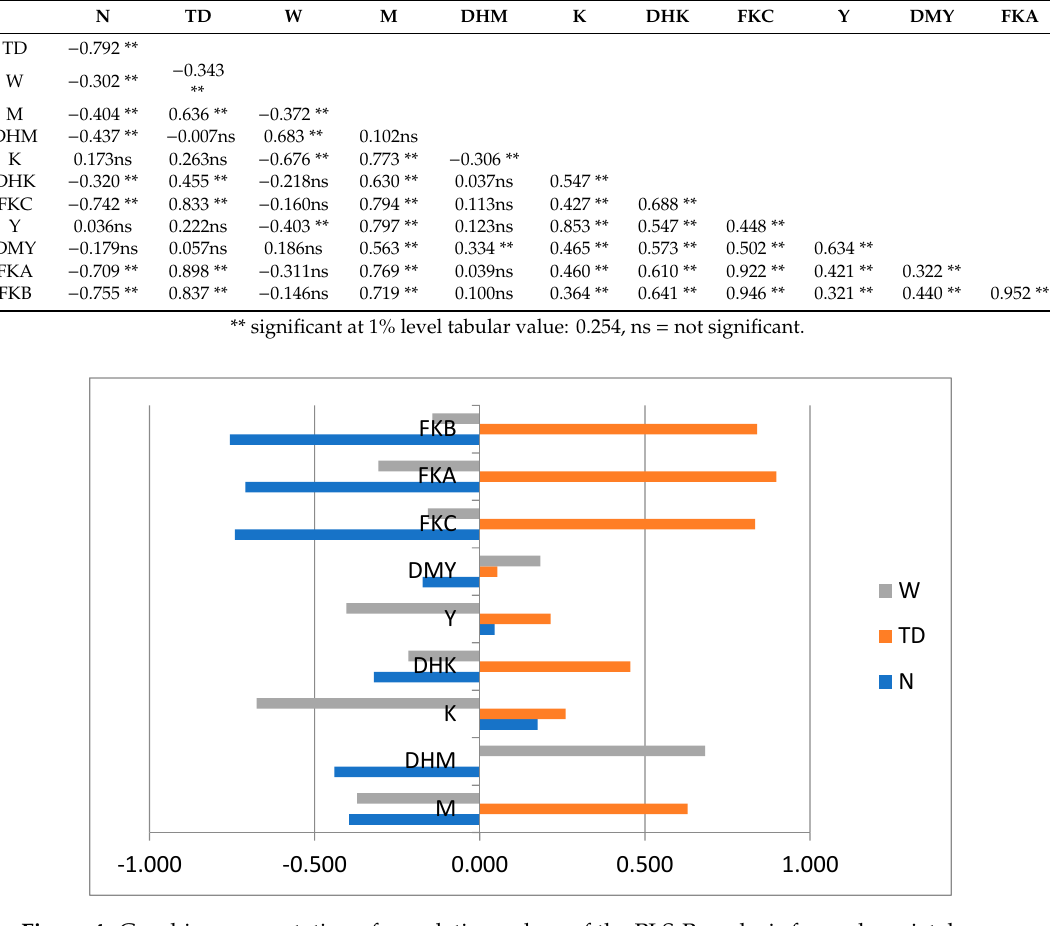
Figure 4. Graphic representation of correlation values of the PLS-R analysis for each varietal group (W = wichmannii, TD = two-day, N = noble) for the 6 KLs and 3 FKs.